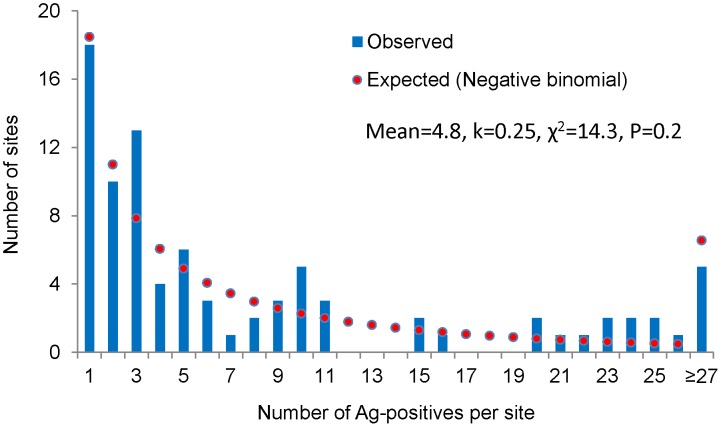
Observed and expected number of sites with antigen positives by zero-truncated negative binomial model.